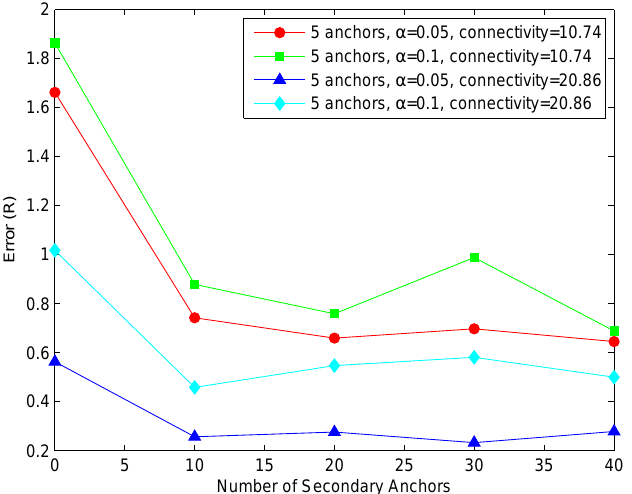
Figure 16 . 5 Anchors, Uniform